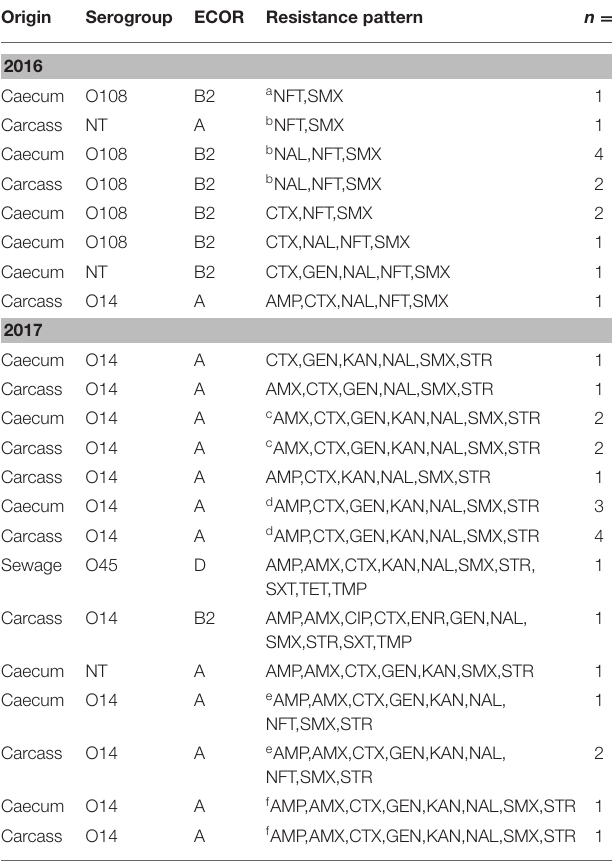
TABLE 2 | Antibiotic resistance patterns of collected aEPEC strains with their origins, phylogenetic groups (ECOR) and O serogroups. Origin Serogroup ECOR Resistance